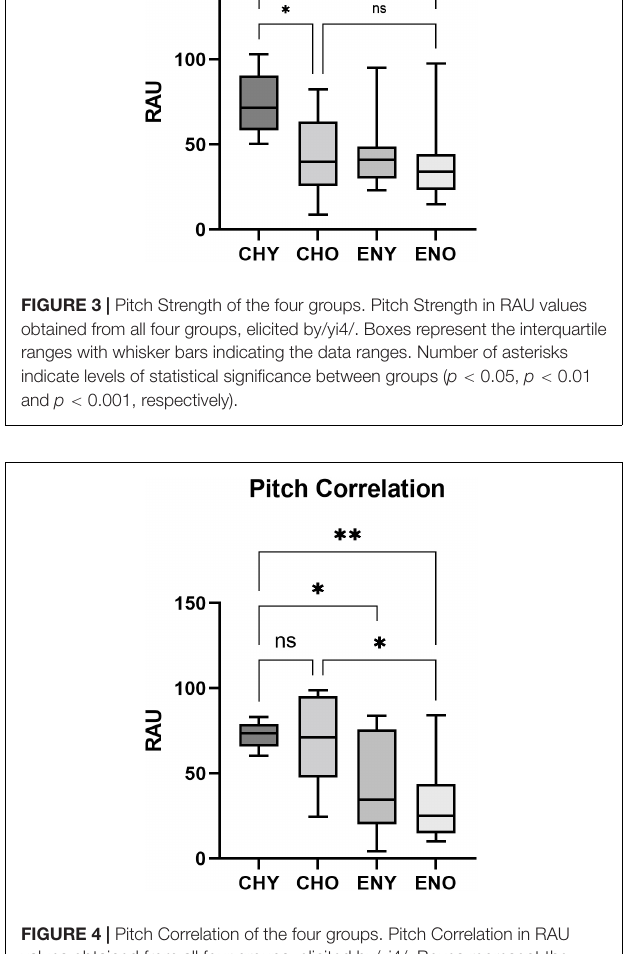
FIGURE 4 | Pitch Correlation of the four groups. Pitch Correlation in RAU values obtained from all four groups, elicited by/yi4/. Boxes represent the interquartile range with whisker bars indicating the data ranges. Asterisks indicate statistical significance found in the factor of language experience ( p < 0.0001,